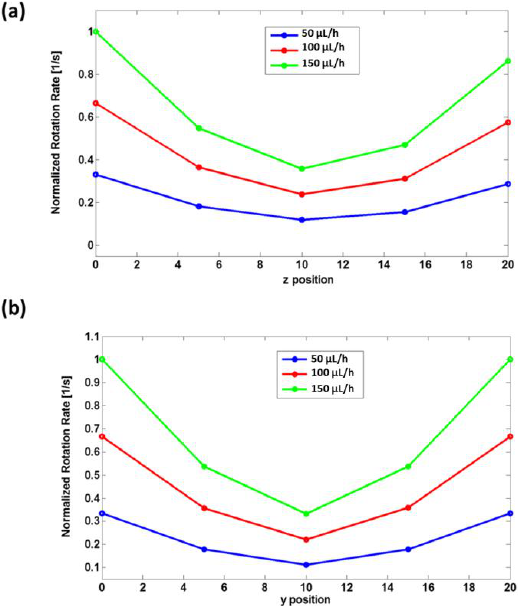
Figure 3. Numerical simulation results. The rotation rate (number of rotation/s) as a function of ( a ) the y horizontal position and ( b ) the vertical position across the channel. Three studies were performed by setting different values for the flow-rate of the fluid at the inlet.